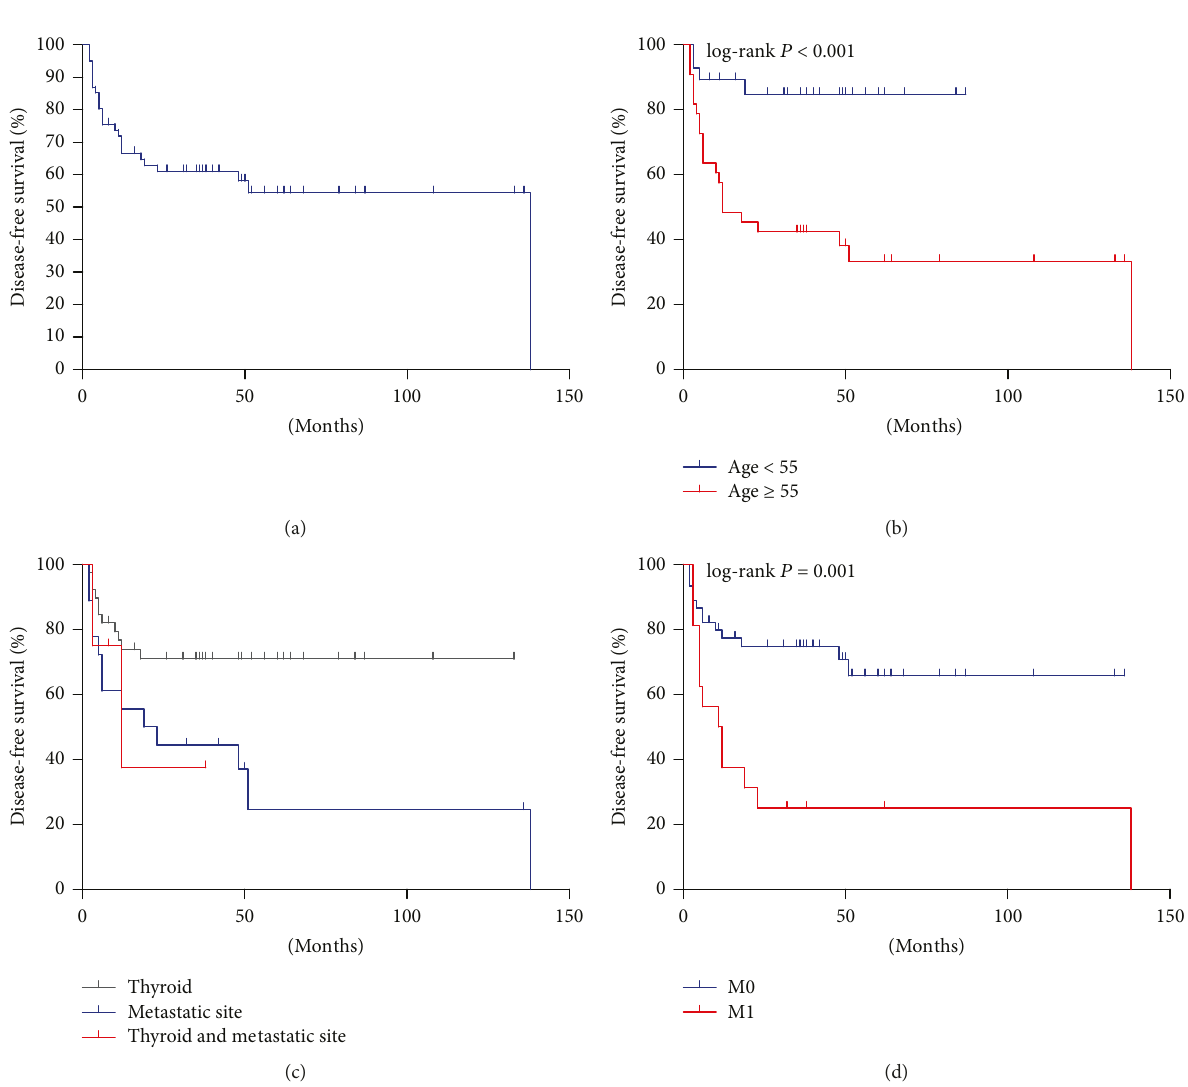
Figure 3: Kaplan-Meier plots of disease-free survival. (a) The survival plot of all dedi ff erentiated patients. (b – d) The survival plots are shown according to age, dedi ff erentiated sites, and distant metastasis (DM), respectively. The survival plot grouped by dedi ff erentiated sites indicated a signi fi cant di ff erence between primary dedi ff erentiation in thyroid and metastatic region dedi ff erentiation ( P = 0 011 ,